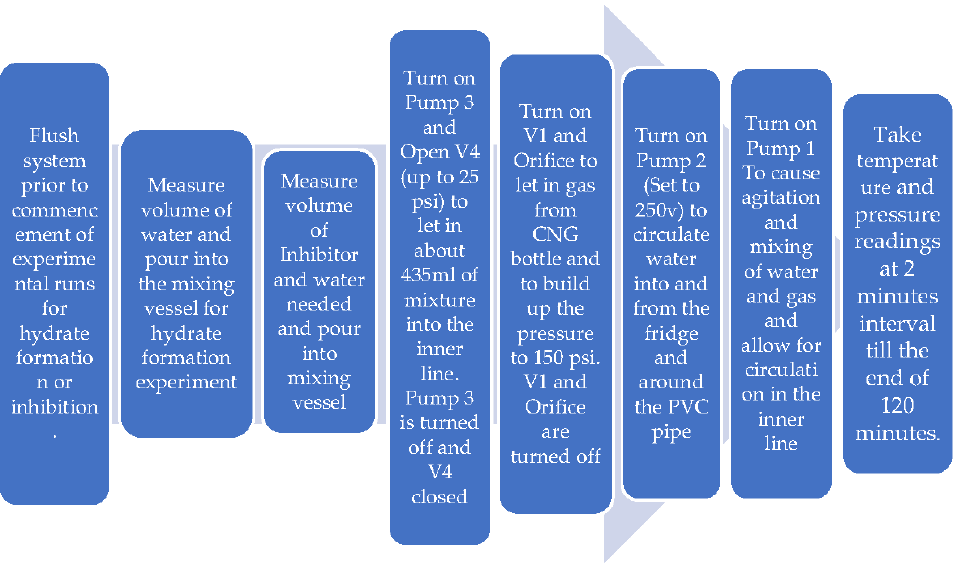
Figure 2. Flow Chart of the Experimental Procedure/Run.